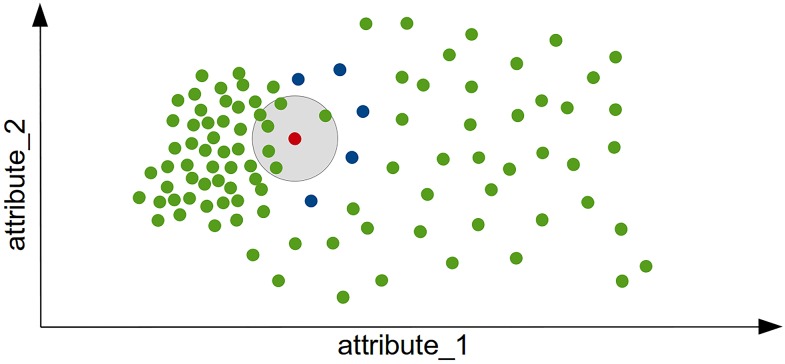
Comparing INFLO with LOF shows the usefulness of the reverse neighborhood set.For the red instance, LOF takes only the neighbors in the gray area into account resulting in a high anomaly score. INFLO additionally takes the blue instances into account (reverse neighbors) and thus scores the red instance more normal.